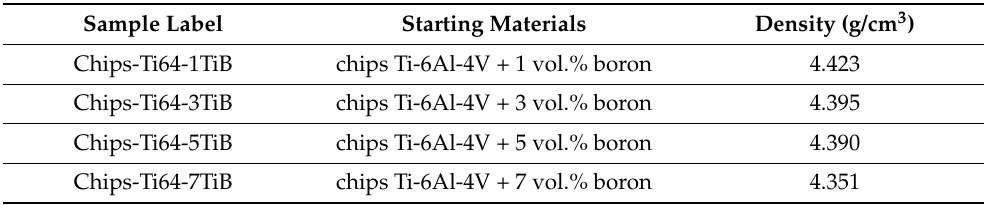
Table 1. Detailed information of Ti-6Al-4V chips with x vol.% of boron addition (x = 1, 3, 5, and 7). Sample Label